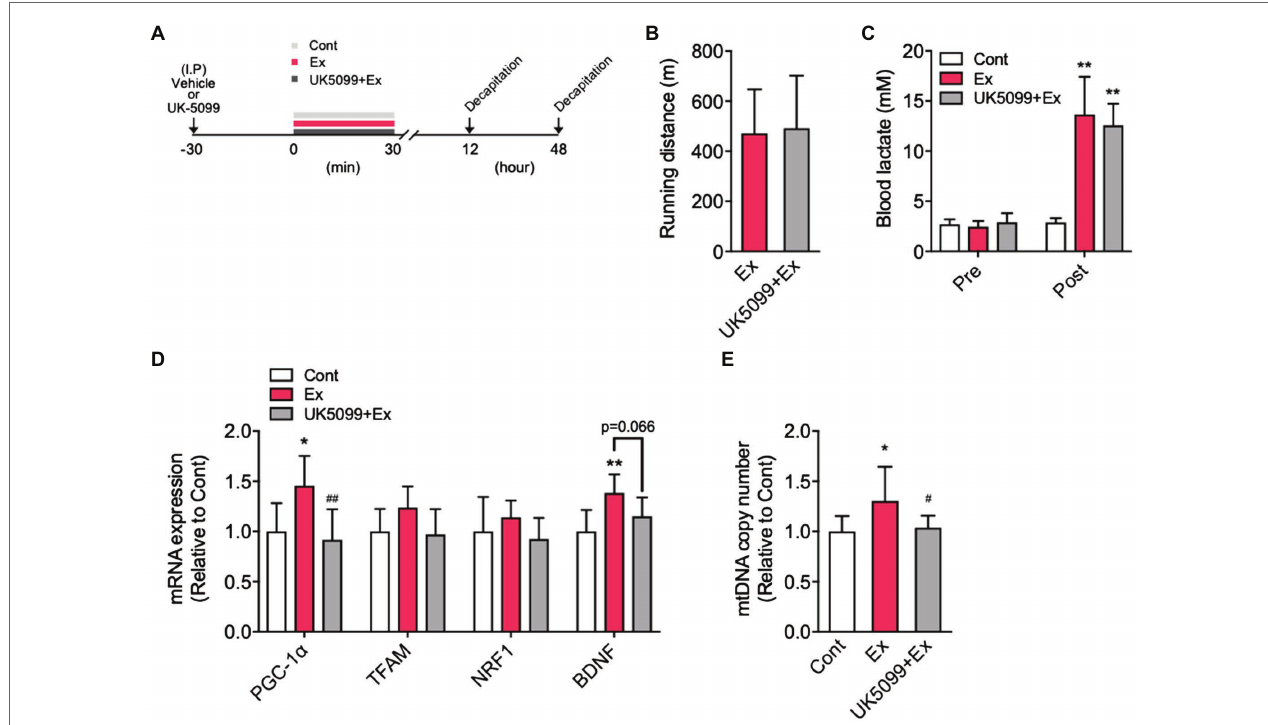
FIGURE 3 | Exercise-induced lactate release increased PGC-1 α mRNA expression and mtDNA copy number in the hippocampus. (A) Experimental design: Mice were injected with saline or UK5099 by I.P. injection 30 min before a single bout of high-intensity exercise. Blood lactate concentrations were measured immediately after exercise. (B) Running distance to fatigue on a treadmill for mice administered saline (Ex) or UK5099 (UK5099 + Ex) before exercise. (C) Blood lactate concentrations before exercise (Pre) and immediately after exercise (Post). (D) PGC-1 α , TFAM, NRF1, and BDNF mRNA expression in the hippocampus 12 h after exercise (Cont, n = 9; Ex, n = 10; UK5099 + Ex, n = 8). (E) mtDNA copy number in the hippocampus 48 h after exercise (Cont, n = 10; Ex, n = 10; UK5099 + Ex, n = 10). All data were presented as the mean ± SD values. Data were analyzed using one-way ANOVA with Tukey’s post-hoc tests. * p < 0.05 and ** p < 0.01 in comparison with Cont group and ## p < 0.05 and ## p < 0.01 in comparison with Ex